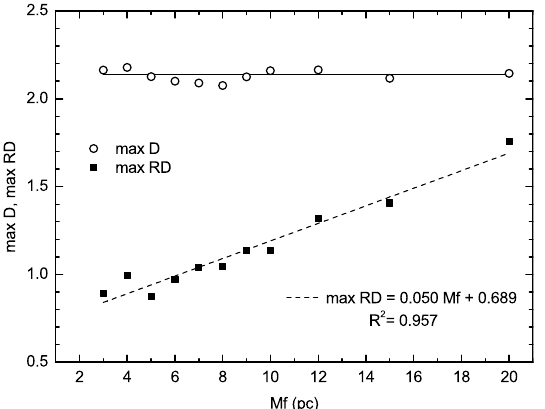
Fig. 6. Maximum fractal dimensions for the real distribution of stars in the solar neighborhood ( D ) and for its random simulations ( RD ).